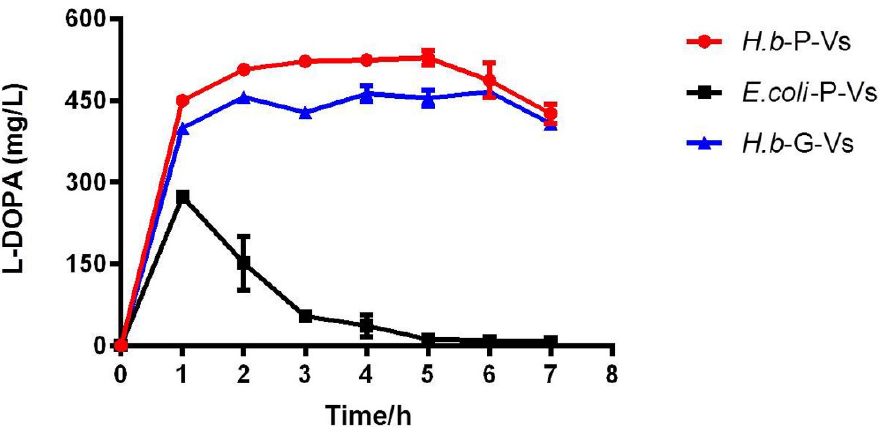
Figure 5. Direct catalysis by cell lysates containing PHA-TyrVs nanogranules from three hosts for L-DOPA production. The cells of three hosts ( E. coli -P-Vs, H.b -P-Vs, H.b -G-Vs) cultured for 48 h were ultrasonically disrupted, and the same volume of cell lysates (150 µ L) was added to produce L-DOPA in 1 mL scale enzymatic reaction, incubated at 50 °C, at 200 rpm lasting for 7 h, with sampling every 1 h. Error bars indicate SD values from triplicate trials.